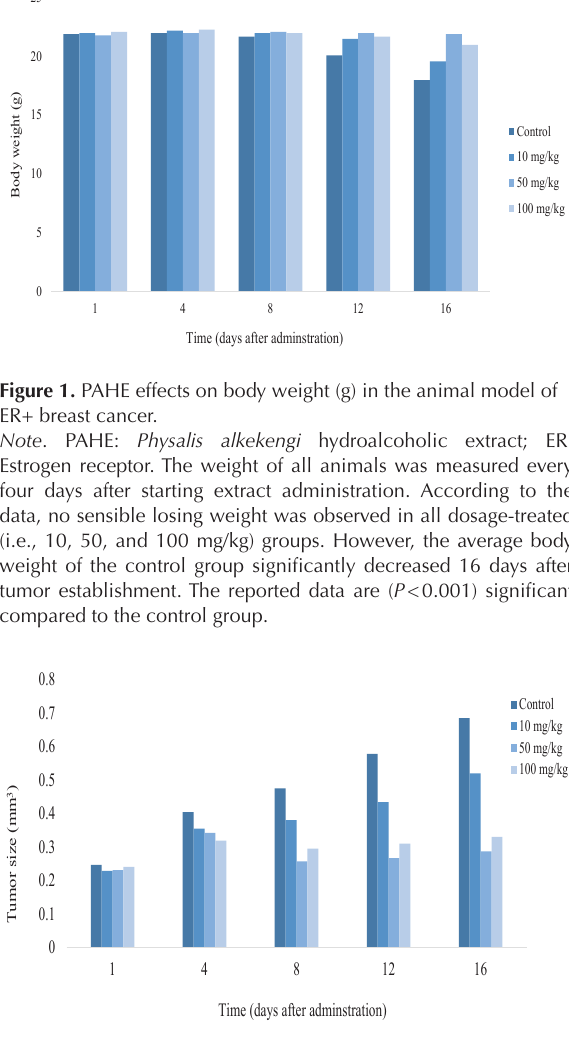
Figure 2. PAHE effects on the tumor size (mm 3 ) in the animal model of ER + breast cancer